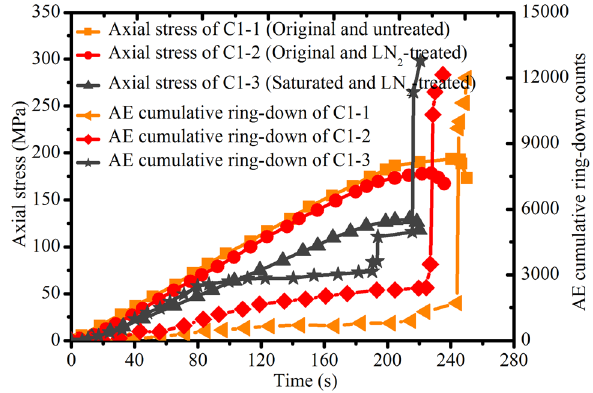
Fig. 10 Temporal variation in axial stress and AE events of shale specimens under triaxial compression